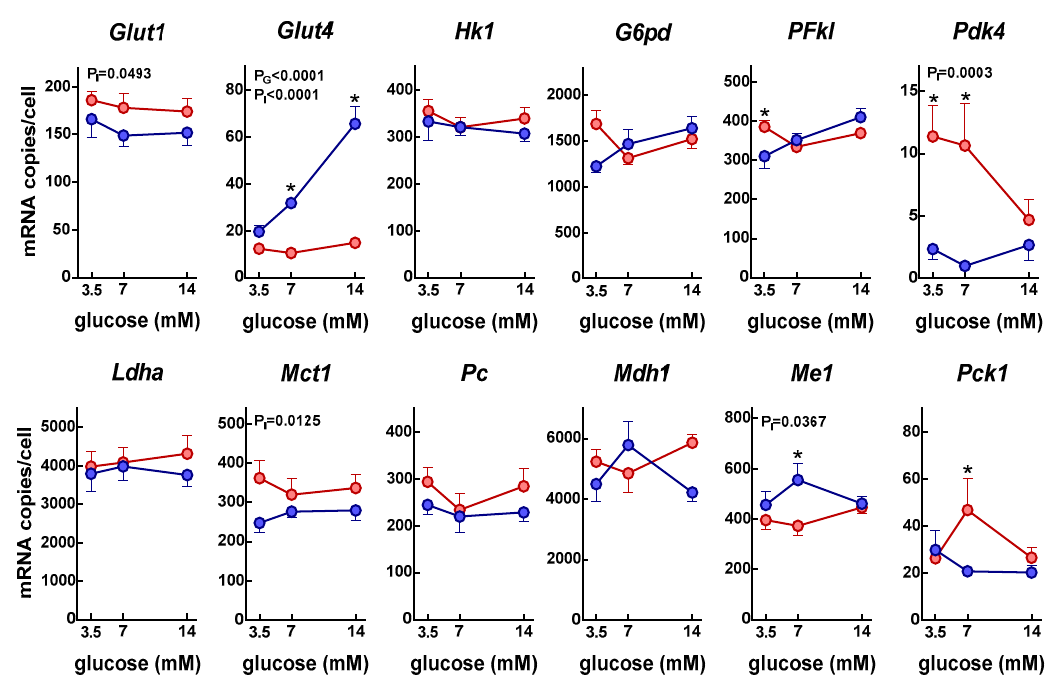
Figure 4. Insulin effect on the gene expressions of proteins related to glucose metabolism in adipocytes incubated under varying glucose concentrations for 24 h. The data are presented as number of the corresponding mRNA copies per cell, and are mean ± SEM of data from six rats. The data were obtained from the “parallel” incubations (i.e., no label). Red circles: adipocytes incubated in absence of insulin; blue circles: adipocytes incubated in presence of insulin. The statistical significance data and conventions are the same as in Figure 1. *post-hoc significant differences between groups with and without insulin of identical glucose concentration. The correspondence between gene names and those of the proteins they code can be seen in Table 1.